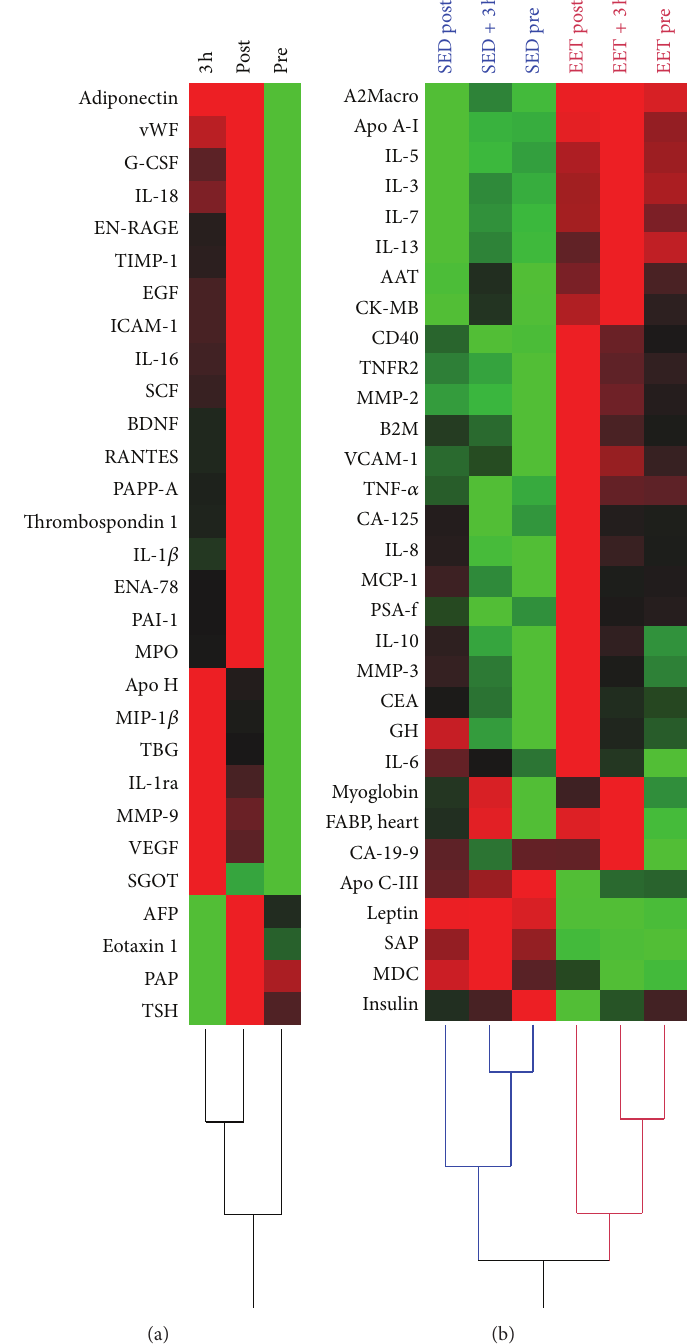
Figure 2: Hierarchical cluster analysis of significant variables with (a) main effect time point and (b) group, group and time, and interaction effect at each time point between EET and SED individuals using Ward’s method. Differences are represented by the computed RTEs. Red colour representing higher and green lower RTEs. EET: endurance-exercise-trained; SED: